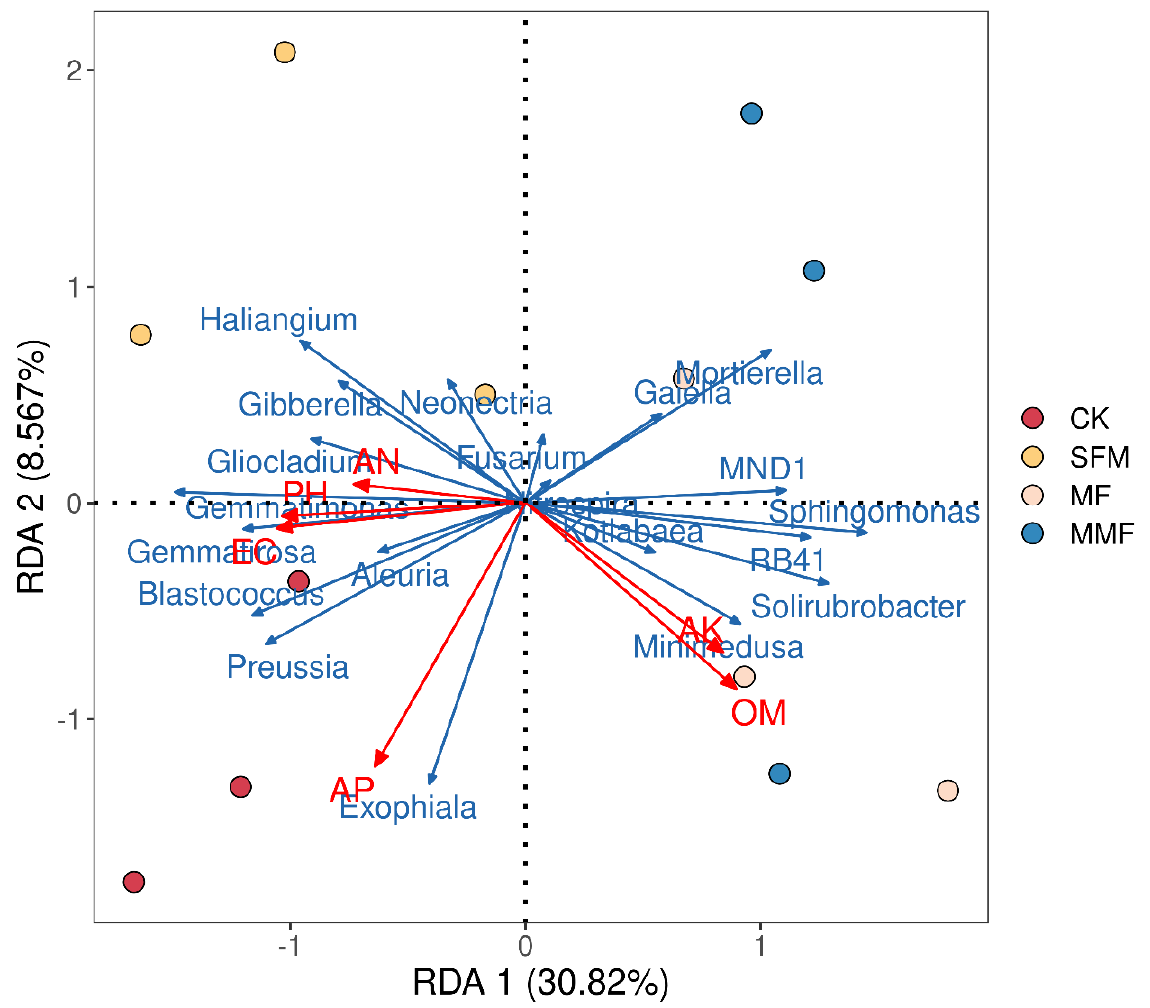
Figure 4. Redundancy analysis (RDA) of microorganism communities and soils physicochemical properties: microorganism included top 10 fungal genera and top 10 bacterial genera; OM, EC, AK, AN, and AP represented organic matter, electrical conductivity, available potassium, alkali-hydrolyzable nitrogen, and available phosphorus, respectively.